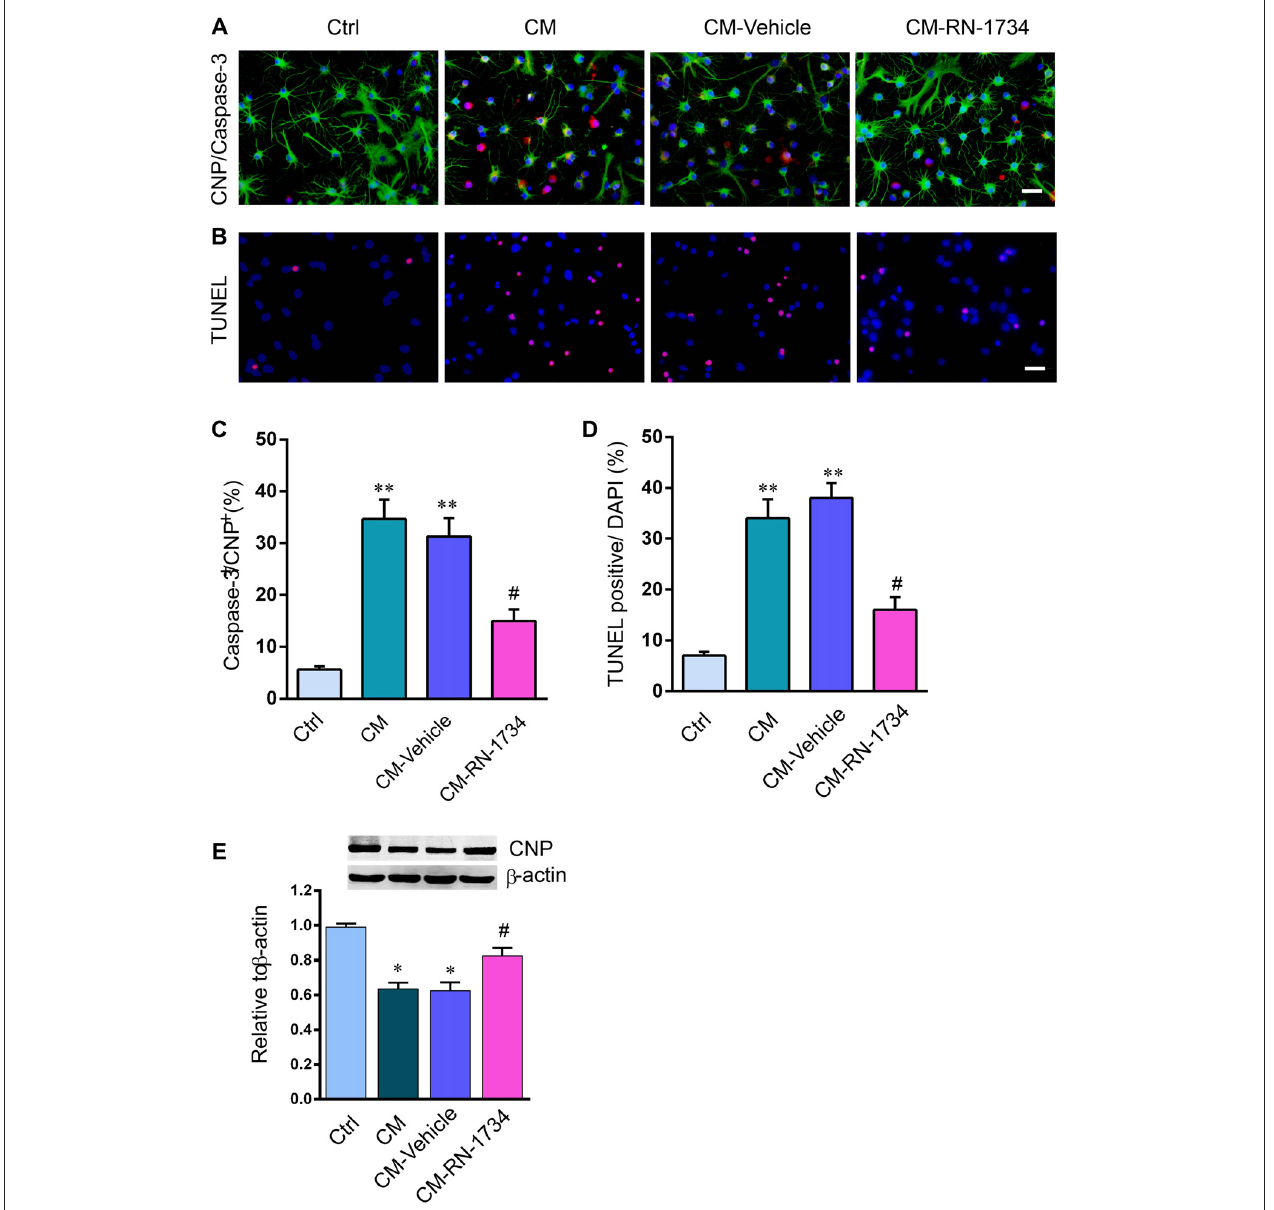
FIGURE 5 | TRPV4 activation in microglia was involved in oligodendrocyte apoptosis in vitro . (A,B) Representative pictures of CNP and cleaved-caspase 3 immunofluorescence double staining and Terminal Deoxynucleotidyl Transferase dUTP Nick End Labeling (TUNEL) staining in the Ctrl, conditional medium (CM), CM-vehicle and CM-RN-1734 groups. (C,D) Quantitative analysis of the percentage of cleaved-caspase 3-positive cells and TUNEL-positive cells. (E) Western blot analysis of oligodendrocyte CNP in the ctrl, CPZ, vehicle and RN-1734 groups. n = 5 per group. The data are expressed as the mean ± SEM. ∗ P < 0.05, ∗∗ P < 0.01 vs. the Ctrl group; # P < 0.05 vs. the vehicle